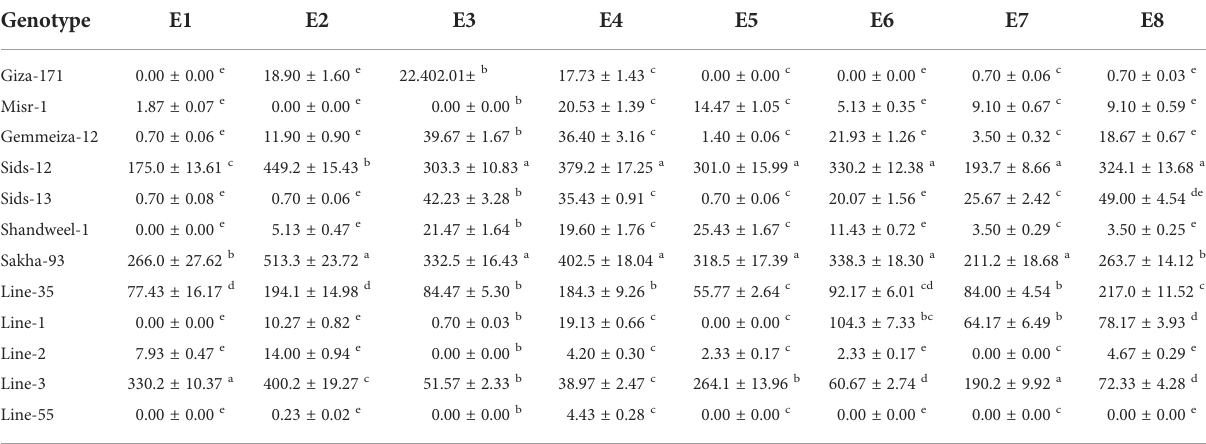
TABLE 5 The area under disease progress curve (AUDPC) of the evaluated twelve bread wheat genotypes in two locations (Kafer El-Hamam and Sakha) during two growing seasons in 2015-2016 and 2016-2017 under timely and late sowing dates. Genotype